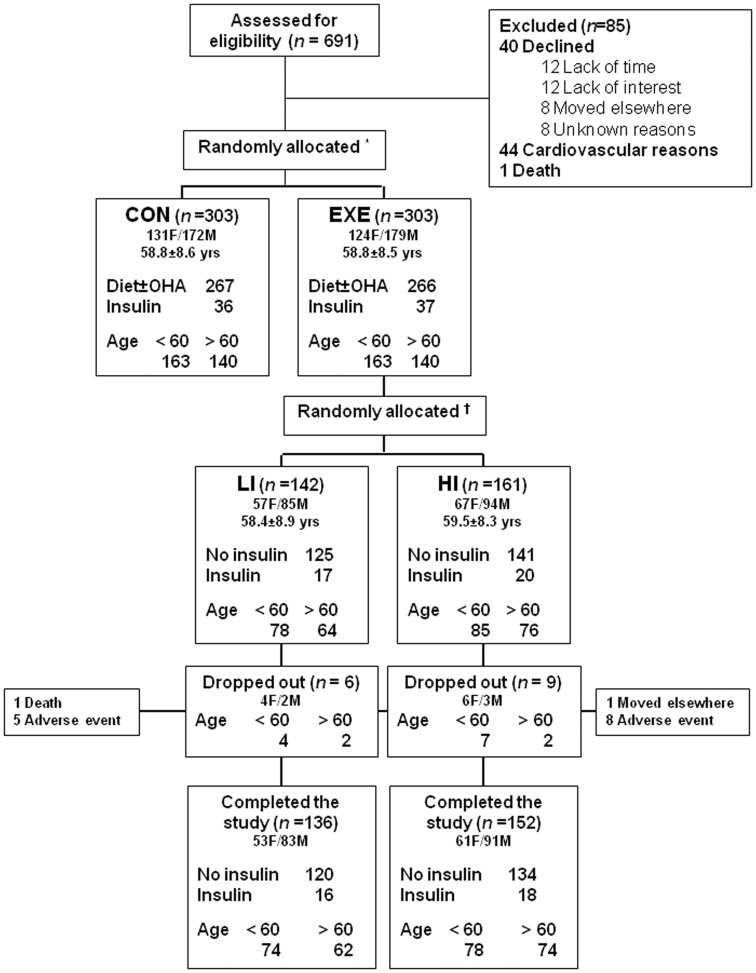
Study flow diagram.* Patients were randomly allocated by center and, within each center, by age (<60 versus ≥60 years) and type of diabetes treatment (no insulin versus insulin) to CON or EXE group and then † EXE participants were further randomized to LI or HI subgroup by center only. CON = control group; EXE = exercise group; LI = low intensity; HI = high intensity.